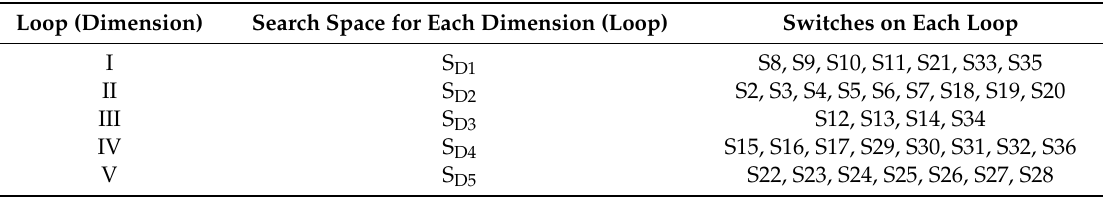
Table 4. The loops of the RMG test system in the SPSO algorithm.